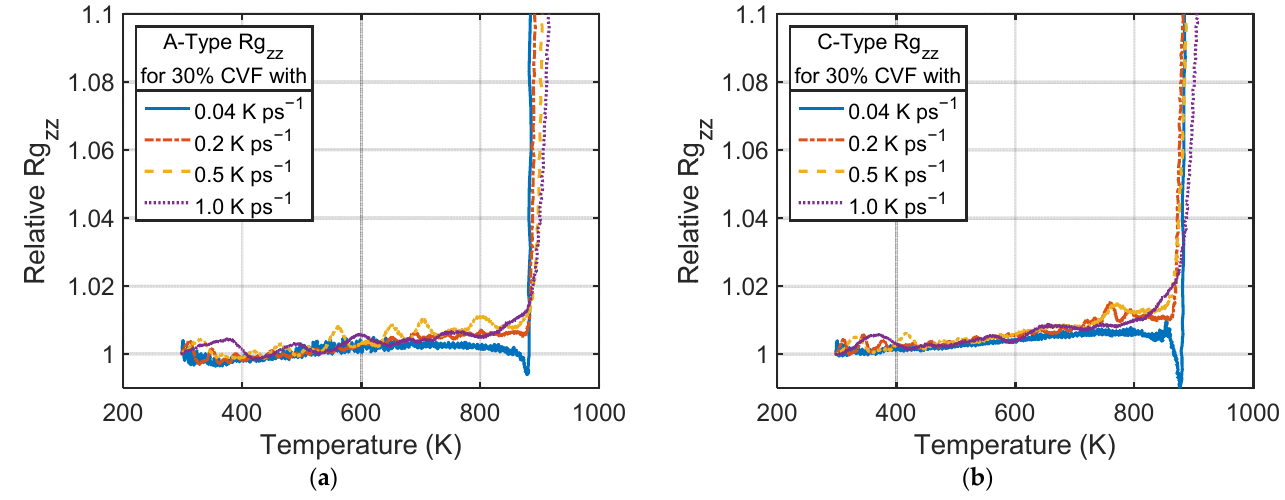
Figure 9. Relative Rg along z -direction (Rg zz ) curves for 30% core volume fraction (CVF) cases with all heating rates in ( a ) the A-type and ( b ) the C-type. Table 2. Corresponding temperature at 10% expansion threshold in z -direction (T Rg ) for both types with 3%, 12%, and 30% core volume fraction (CVF) NPs under 0.04, 0.2, 0.5, and 1.0 K ps − 1 heating rate (HR) melting processes.